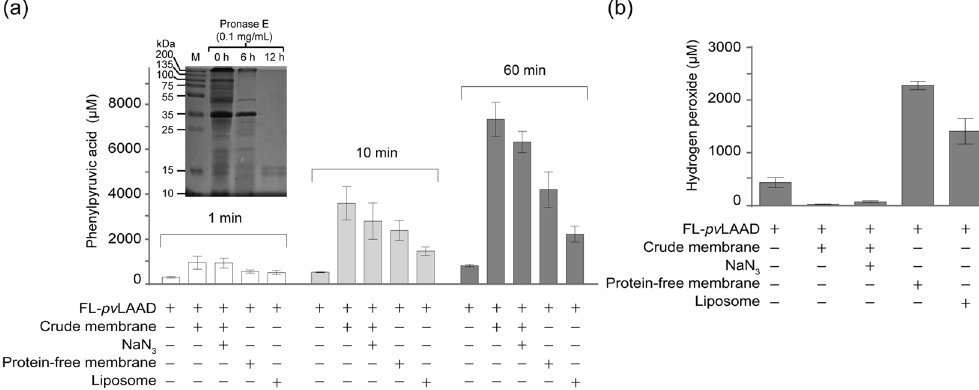
Figure 1. Membrane binding enhances pv LAAD activity. ( a ) Catalytic activities of pv LAAD with or without membrane presence were tested by measuring the transformation of L-phenylalaine to phenylpyruvic acids (PPA) in 1, 10 and 60 min. The activity of full-length pv LAAD with E. coli crude membrane was significantly enhanced compared to that without membrane, and the enhancement was only slightly reduced by adding the cytochrome oxidase inhibitor sodium azide. Pronase E-treated protein-free membrane, as well as the liposome, also holds the capability to enhance the enzymatic activity, although the fold change is smaller than crude membrane. The results here and later are all from three independent assays, and the error bars are SEM (standard error of the mean). The inset shows that almost all of the proteins on the E. coli crude membrane have been digested after 12 hr of treatment with 0.1 mg/mL pronase E at 37 °C. ( b ) The production of H 2 O 2 was measured by HRP-coupled methods. Significant enhancement of H 2 O 2 production in the reactions containing protein-free membrane and the liposome, indicating the O 2 was used as the substrate by pv LAAD in the deamination of amino acids. H 2 O 2 production has not been detected in the reactions with the crude membrane, which might be due to the strong catalase activity associated with crude